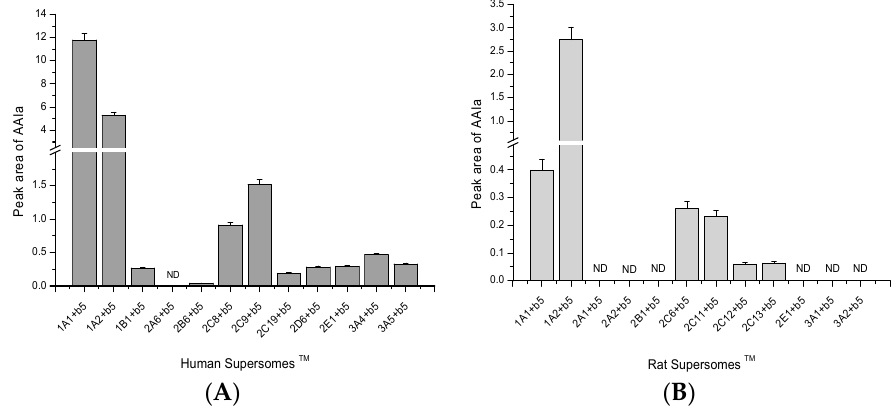
Figure 2. AAI O -demethylation to AAIa catalyzed with Supersomes™, each with a different human recombinant CYP ( A ) and rat recombinant CYP; ( B ) having these CYPs in combination with cytochrome b 5 (b 5 ). Data are averages ± SD of three parallel measurements ( n = 3). ND, not detected. Data previously published in [30,41,43].